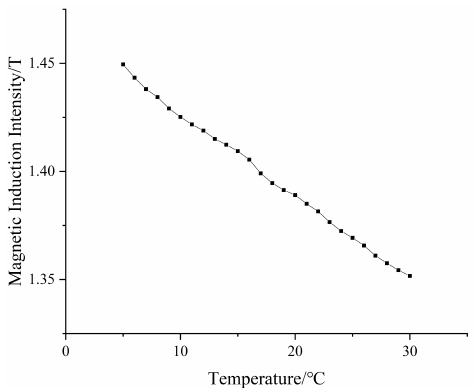
Figure 15. Temperature characteristic curve.